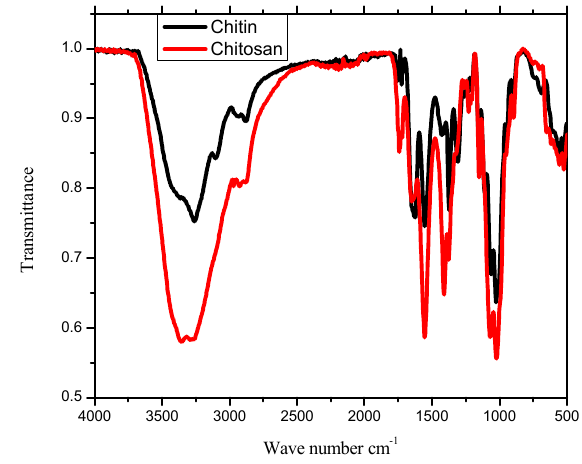
Figure 2. IR spectra of chitin and chitosan.